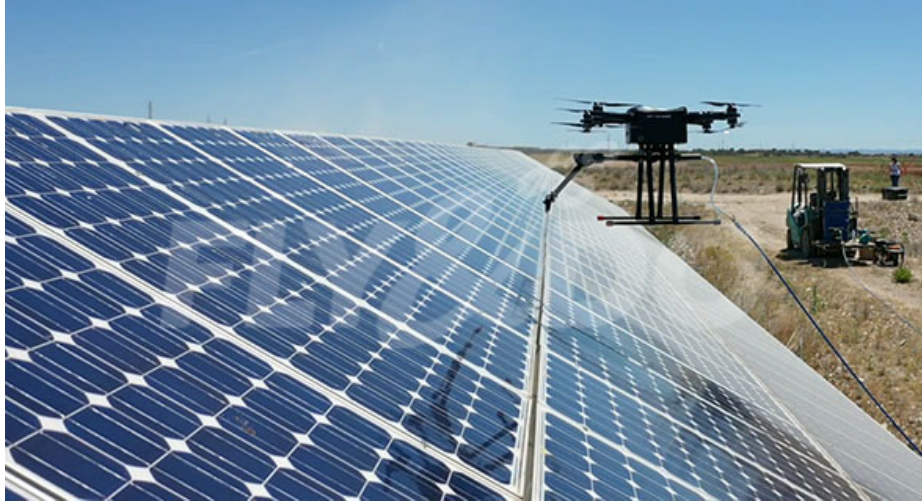
Figure 39. Drone-based PV cleaning [160].